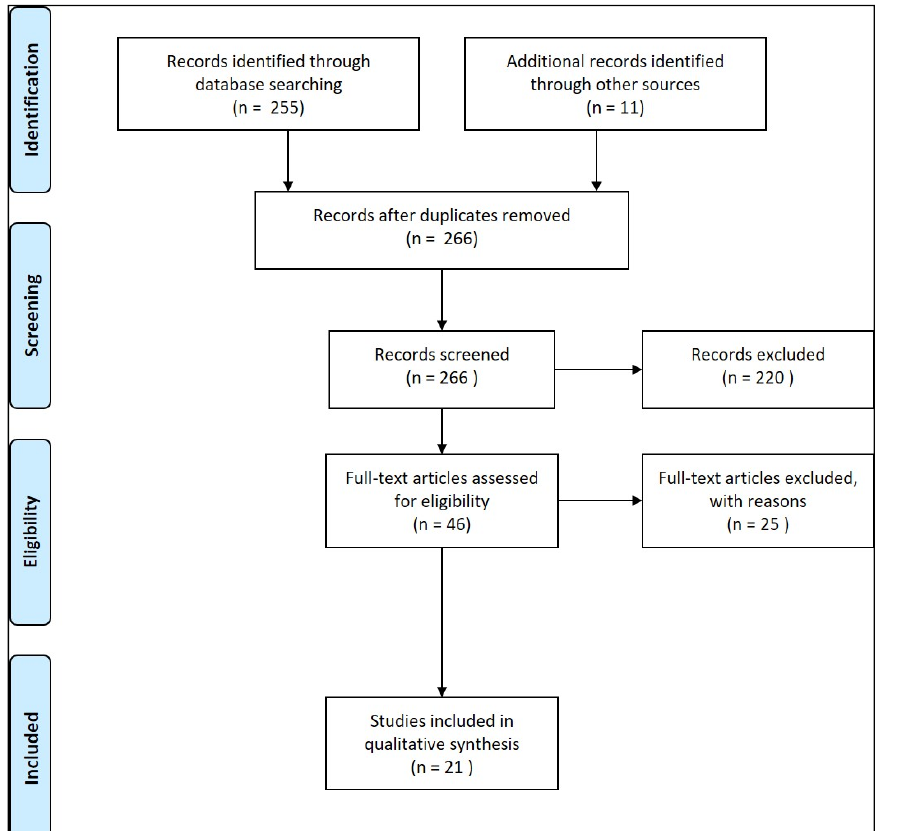
Figure 2. Flow chart of the literature search. Table 1. Studies obtained by the systematic literature search on optical diagnosis of gastrointestinal neoplasia. Developments in the field of endomicroscopy and artificial intelligence are not dis- cussed, as these promising methods are currently reserved for individual, specialized centers or because there are only a few clinical studies available. For Barrett’s esophagus and duodenal neoplasms, the limited data available do not yet allow a statistically reliable assessment of the depth of invasion [35]. Endoscopic ultrasound performed during diag- nostic endoscopy allows for T-staging of early cancer and on subepithelial lesions arising in intramural echo structures with high accuracy, especially, when high-resolution probes are used [36]. In squamous cell lined esophagus, stomach and rectum both techniques it